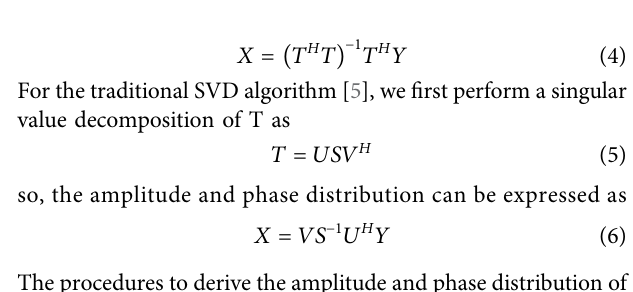
FIGURE 4 | Cross-sectional (A) Amplitude error (B) Phase